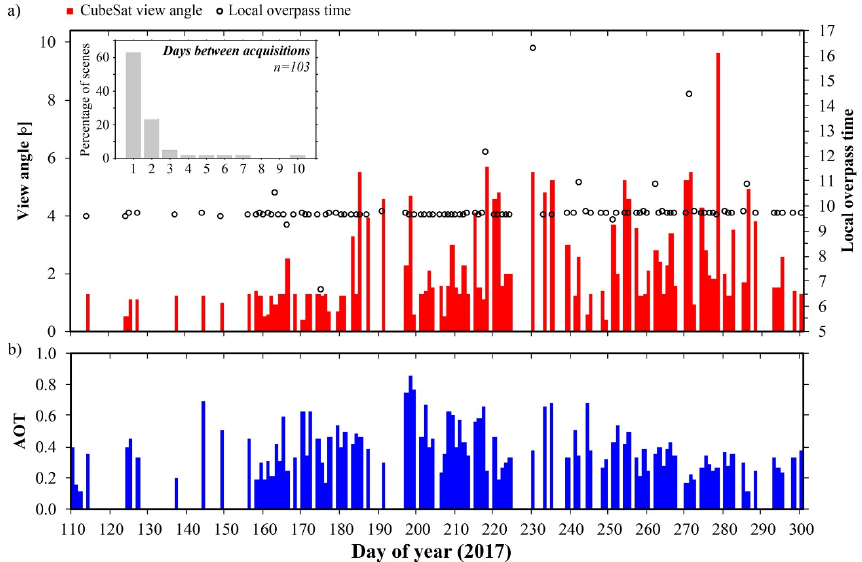
Figure 3. ( a ) Sensor view angle and local overpass time for clear-sky CubeSat imagery acquired